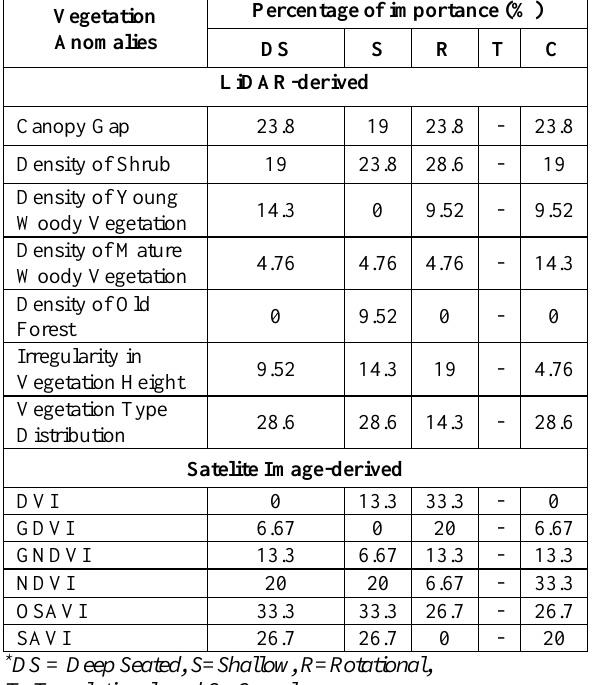
Table 6. Vegetation anomalies index in percentage for active landslide activity with different landslide type